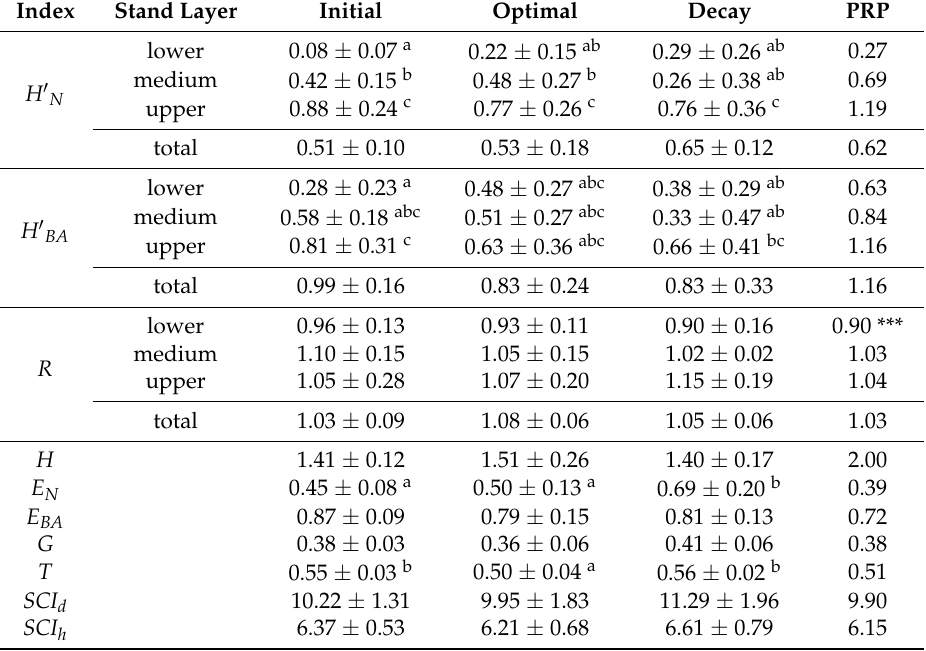
Table 4. Values of structural indices according to development stages and stand